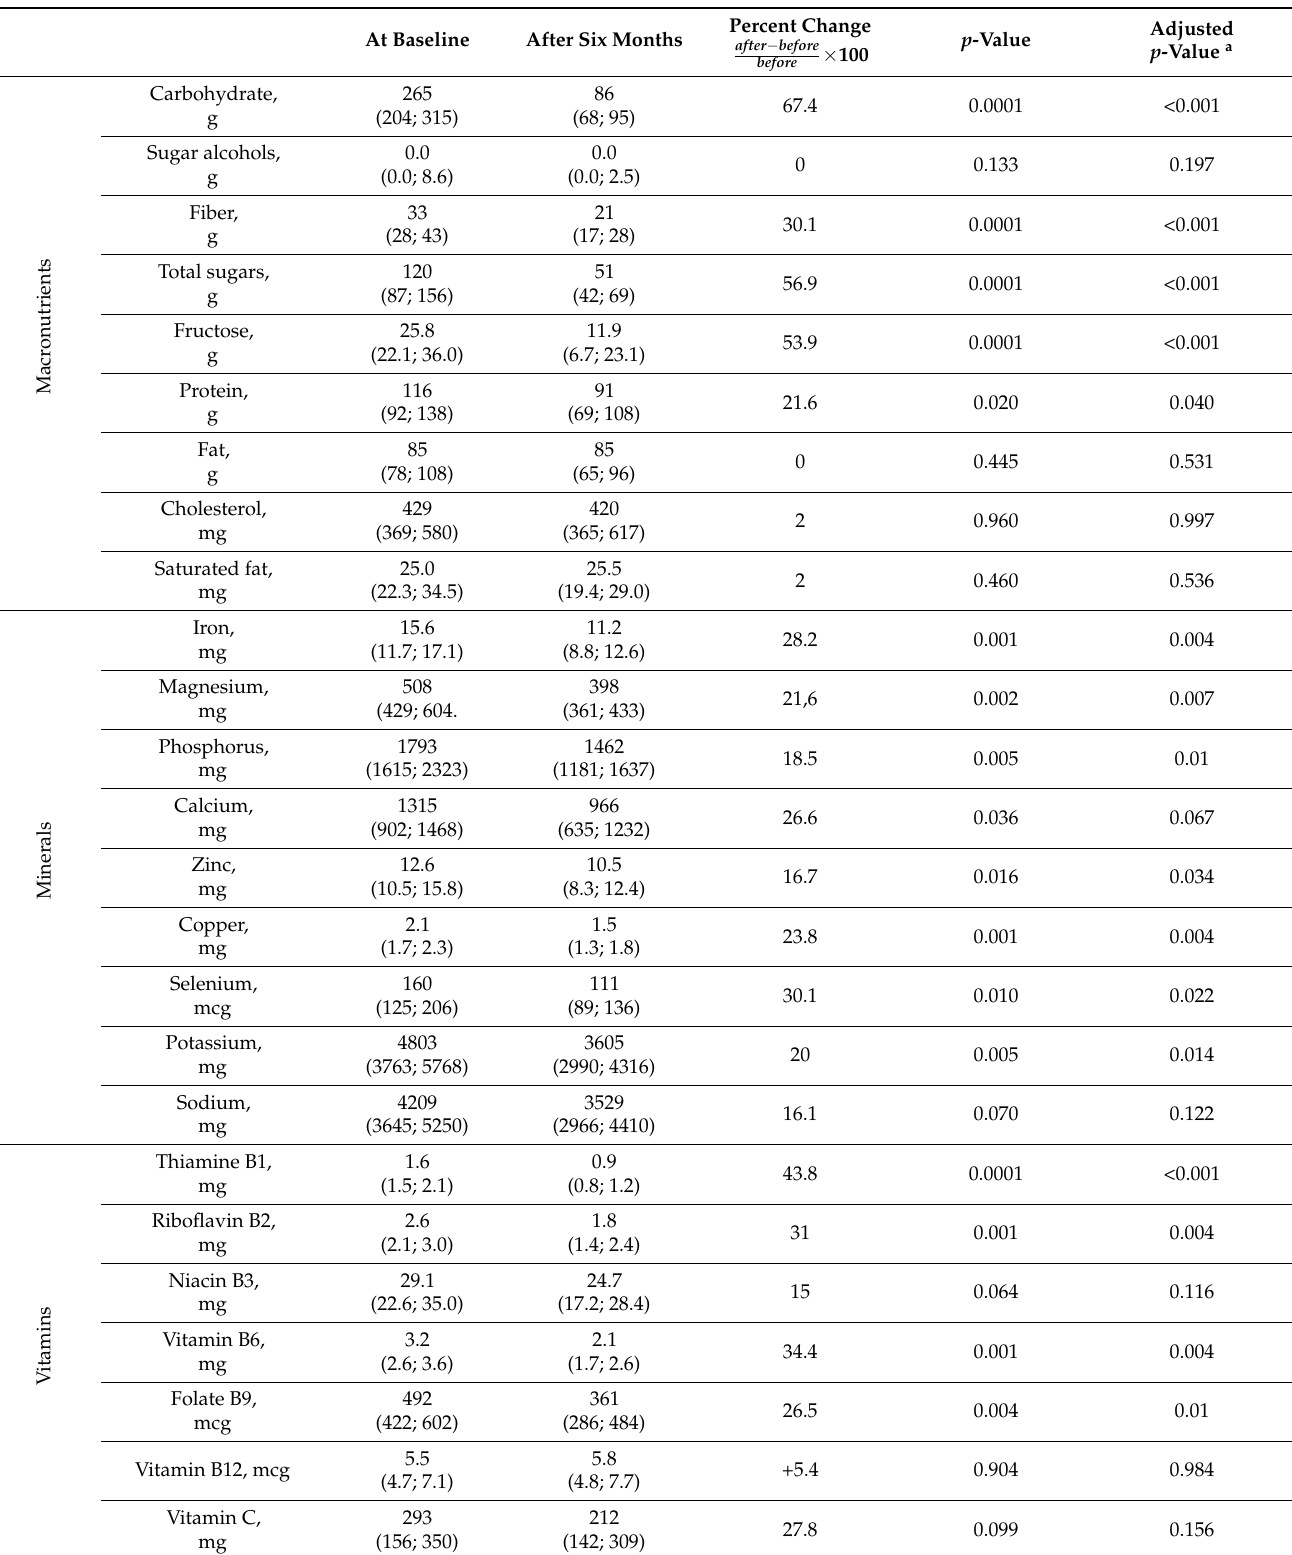
Table 1. Median (interquartile range) intakes of selected nutrients before and after a low-carbohydrate diet, according to the Food Frequency